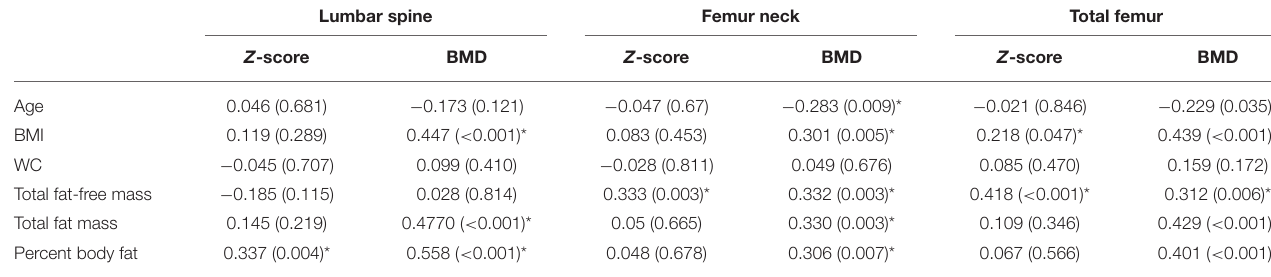
TABLE 3 | Pearson correlation and p -values for Z -scores, and bone mineral